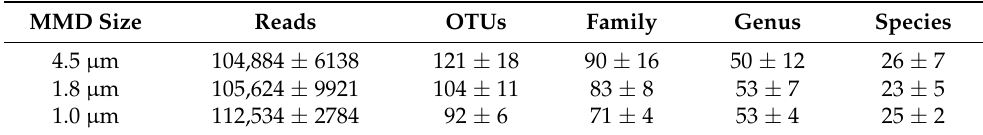
Table 3. Metagenome analysis of 16S rDNA extracted from aerosol particles collected with the air suction devices.